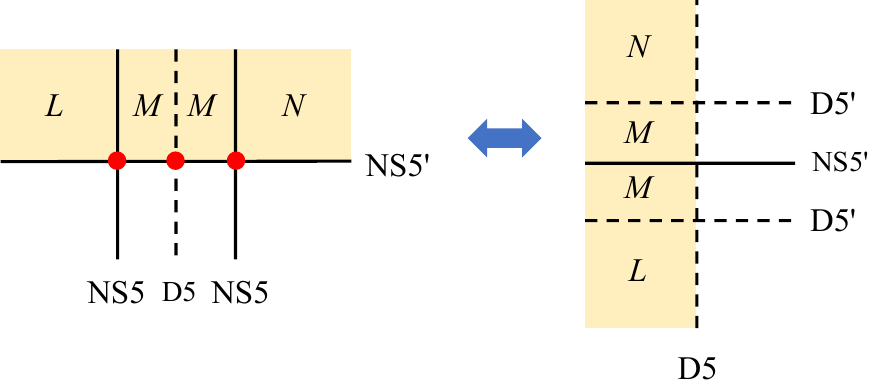
Figure 17 . The brane constructions of the configuration 4d U( L ) and its mirror corner configuration that has no gauge symmetry. Neumann b.c. N (cid:31) 4d U(1) gauge theories with Neumann b.c. (